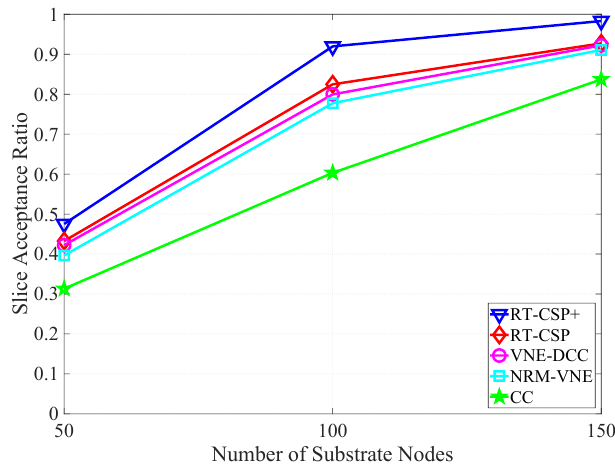
Figure 8. Slice acceptance ratio in the different sizes of substrate network